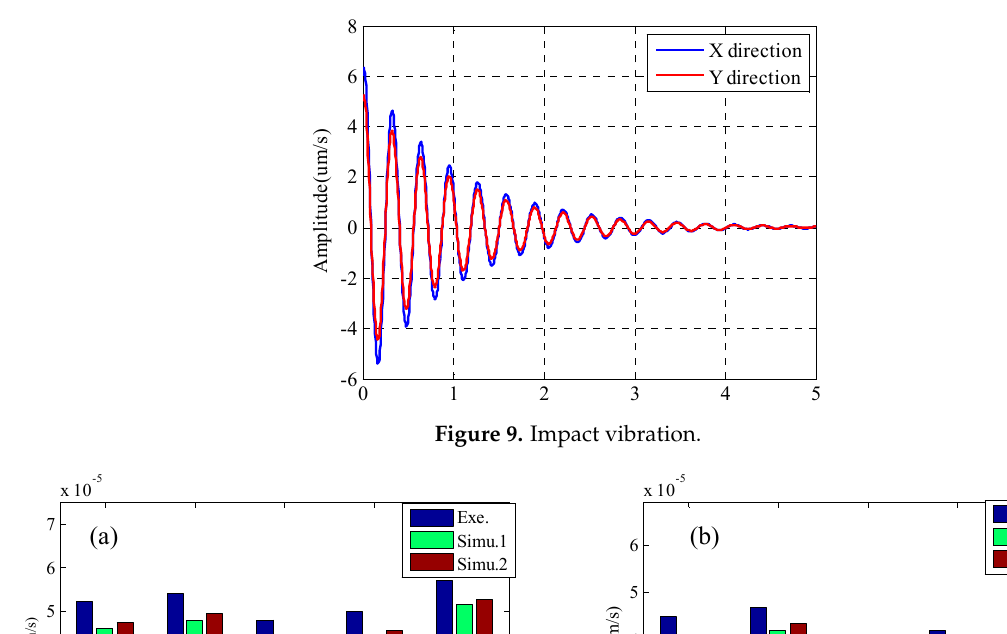
Figure 9. Impact vibration.